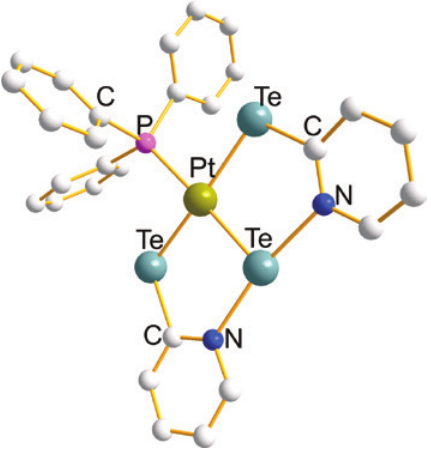
Figure 3: Structure of [Pt(PPh 1996). Figure 4: Structure of [Pt(PPh